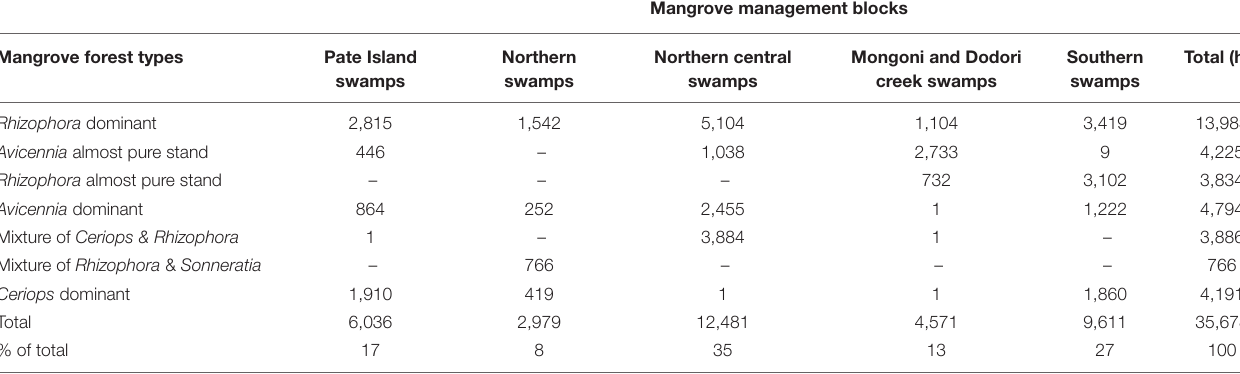
TABLE 2 | Distribution of mangroves cover (ha) in Lamu, Kenya.